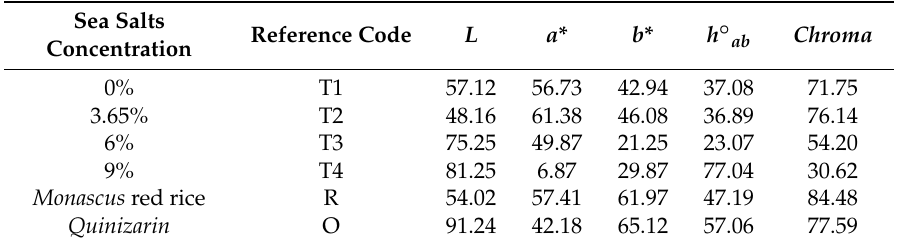
Table 5. L , a *, b *, C , and h ◦ values of T. albobiverticillius 30548’s production on day 10 (culture in PDB supplemented with sea salts, initial pH 4.0, 200 rpm of agitation rate). Monascus red rice and quinizarin (1g/L) used as reference standards.